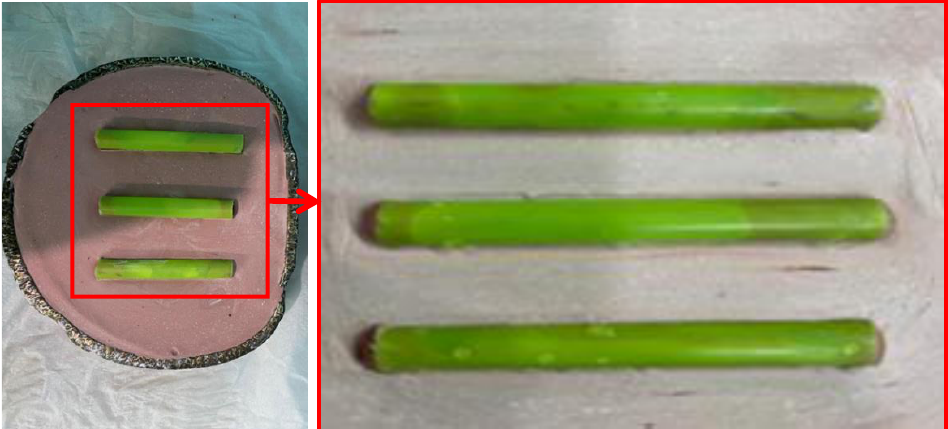
Figure 2. An image for the metal flask with the wax specimens invested and a magnified region of the wax specimen.